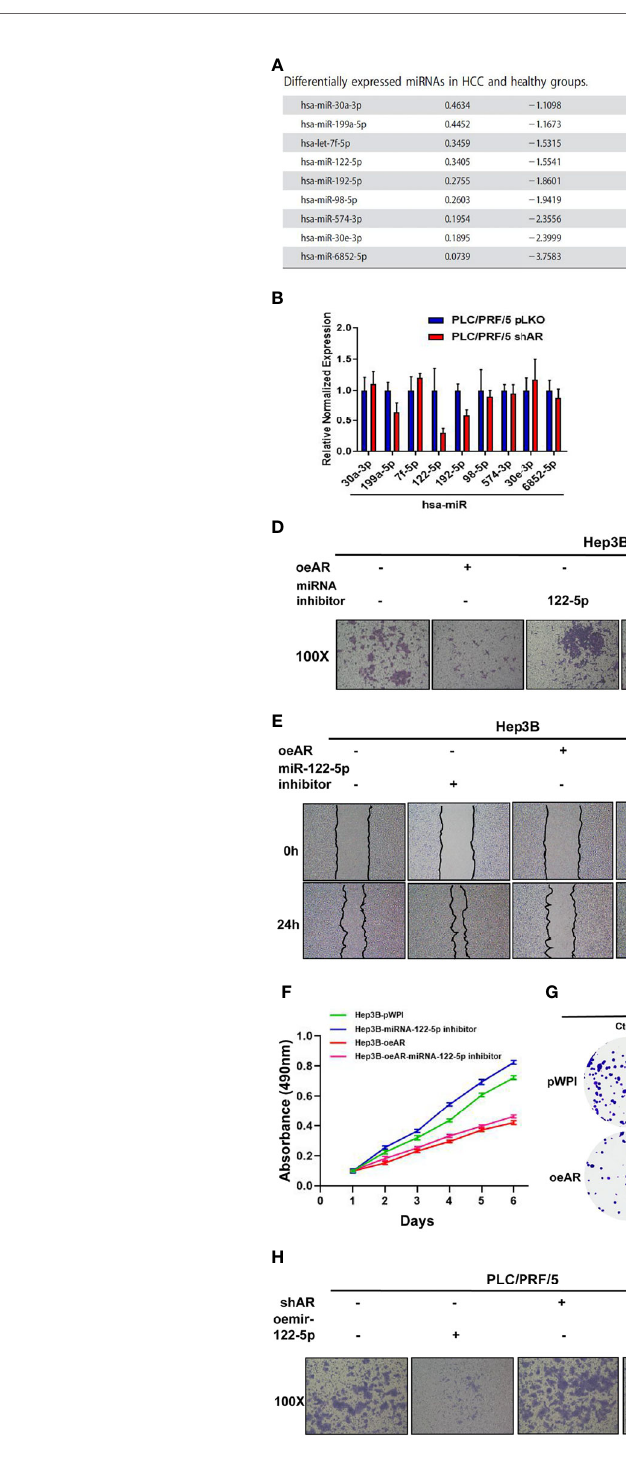
FIGURE 2 | AR may decrease HCC progression via altering miR-122-5p expression. (A) 9 downregulated miRNAs was selected from the published papers. (B, C) qRT-PCR assay was used to check the miRNAs expression after shAR/oeAR in HCC cells. (D) Transwell invasion assay was used to check the invasion capacity of HCC Hep3B cells transfected with pWPI/oeAR after adding miR-122-5p inhibitor or miR-192-5p inhibitor in the cells. (E) Wound healing migration assay was used to check HCC Hep3B cells migration capacity after oeAR/adding miR-122-5p inhibitor in the cells. (F, G) MTT and colony formation assays were used to check HCC Hep3B cells proliferation capacities after oeAR/adding miR-122-5p inhibitor in the cells. (H) Transwell invasion assay was used to check HCC PLC/PRF/5 cells invasion capacity after shAR/oemiR-122-5p in the